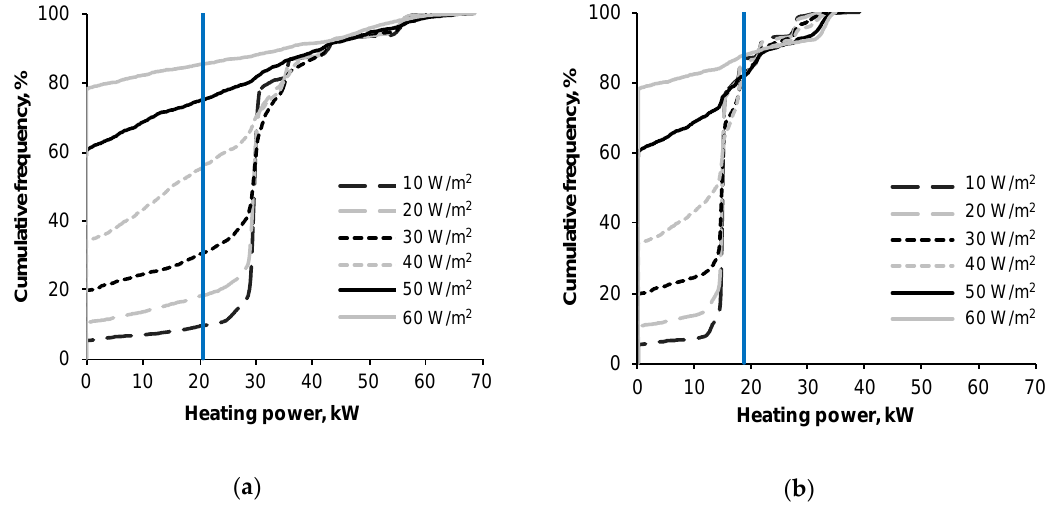
Figure 6. Cumulative distribution of the instantaneous heating power necessary for workplace heating using central heating (50-workplace case), from 16 ◦ C ( a ) and from 18 ◦ C ( b ) and the total heating power for a local system